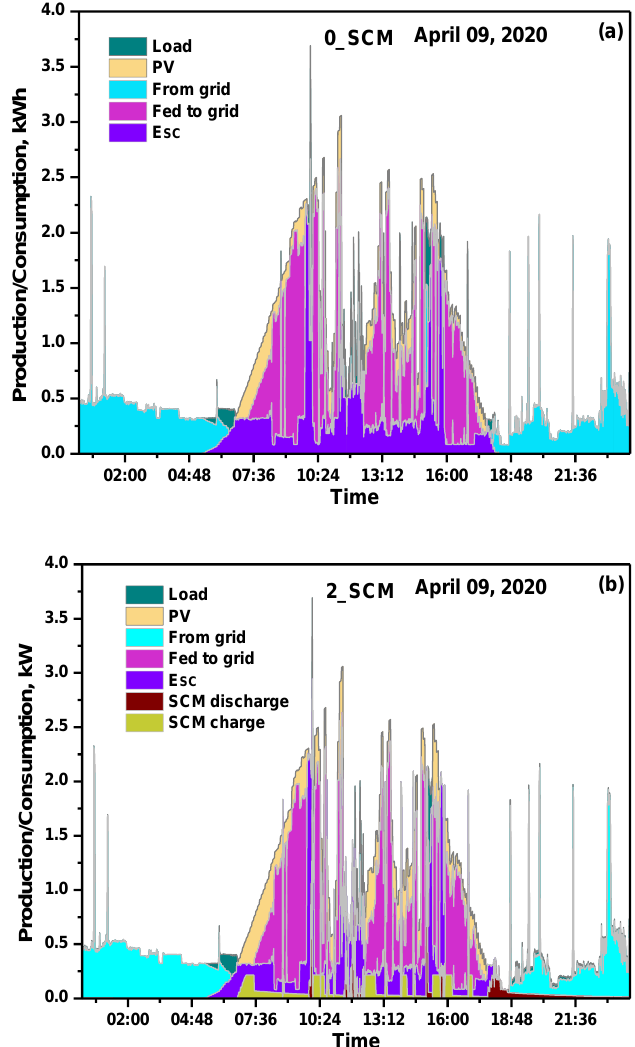
Figure 6. Power distribution for the partly cloudy day 9 April 2020 for 0 SCM units ( a ) and 2 SCM units ( b ), respectively.